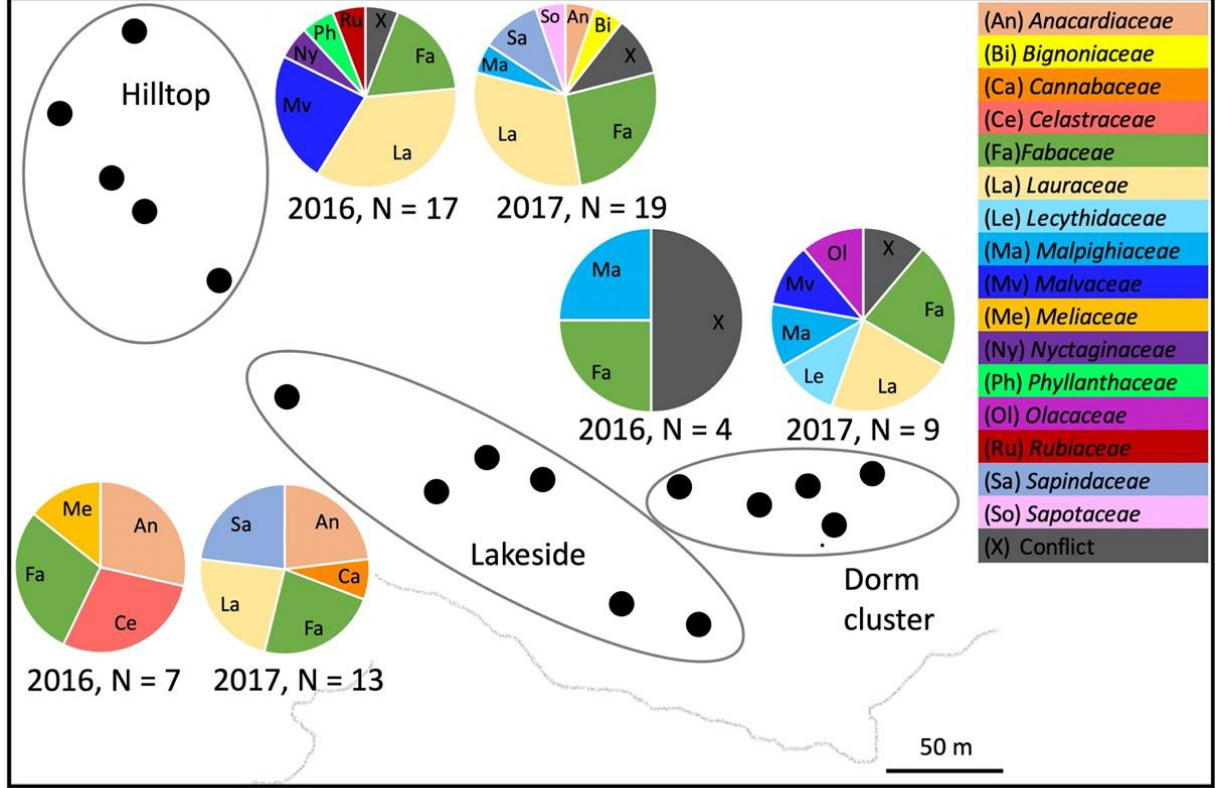
Figure 2. Map of katydid collection localities on Barro Colorado Island, with pie charts representing the plant families that were recovered from katydid stomachs by location and year. Each black dot represents a light capture location, with lights divided into three spatially and elevationally clustered zones. The inset pie charts represent the plant families that were sequenced in a given zone and year. “Conflict” indicates that different primer sets show different plant species identifications for a given individual katydid.